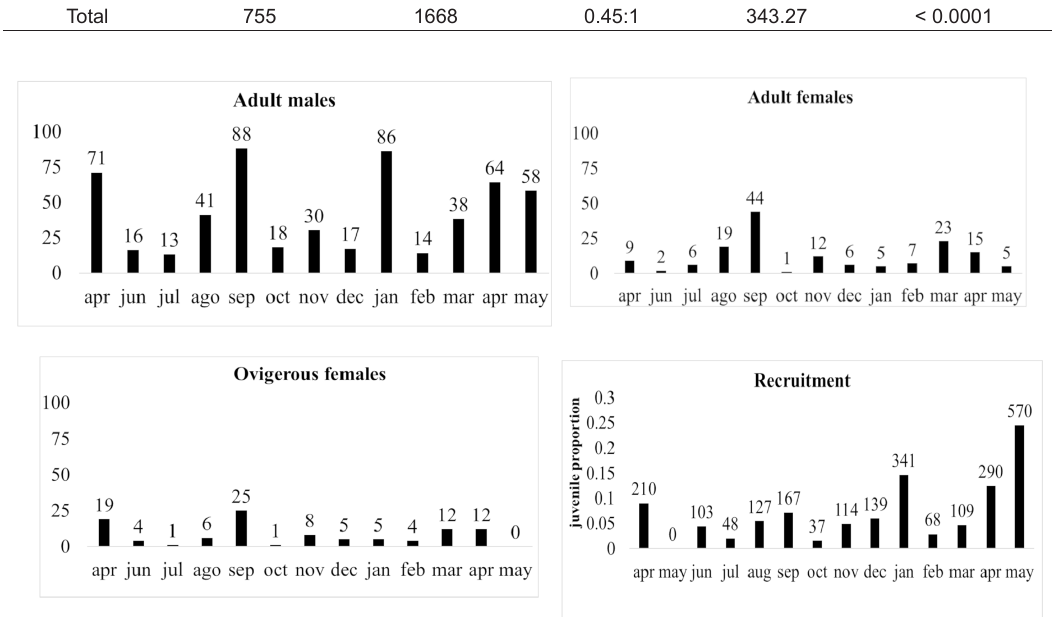
Figure 3. Monthly frequency of individuals in a population of Macrobrachium amazonicum in Miranda dam (MG) between april/2012 and may/2013 according to their population category and recruitment